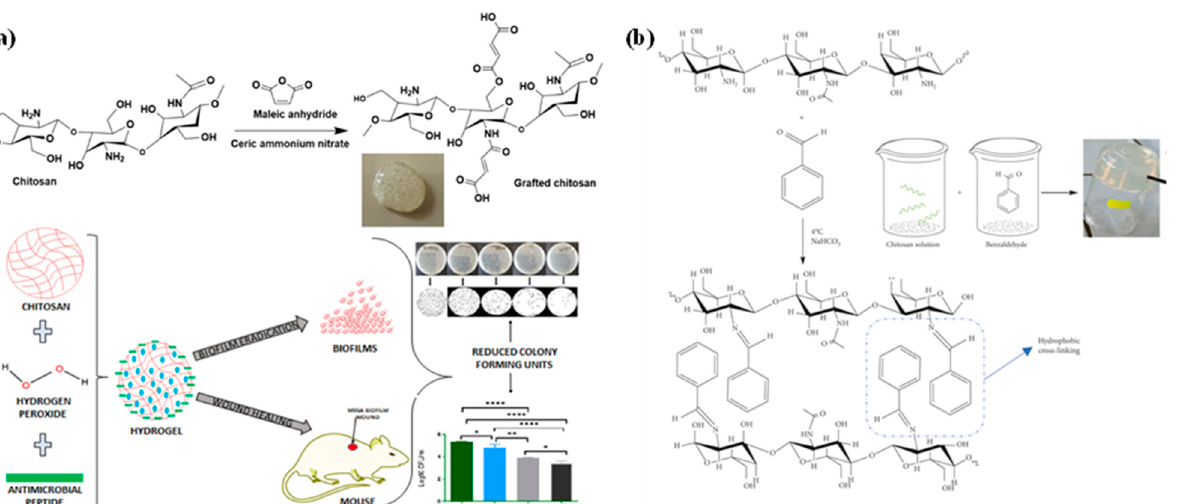
Figure 10. ( a ) Chitosan-based hydrogel preparation using maleic anhydride towards anti-microbial applications, ( b ) the preparation of chitosan-based hydrogels using benzaldehyde using lyophiliza- tion method, adopted from open access resource [39,40].